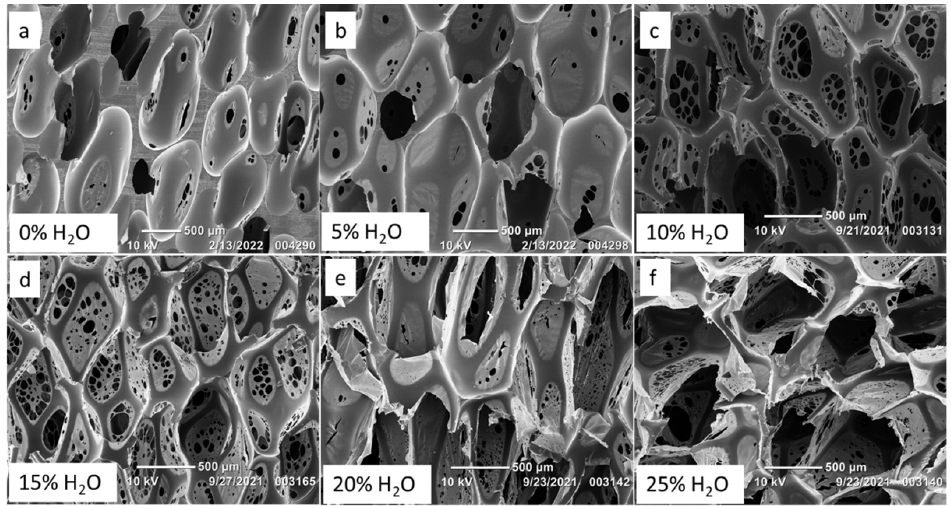
Figure 1. Scanning Electron Microscope (SEM) images of SMP foams synthesized with varying molar percentage of water. Increasing pore sizes and pinhole formation was observed in SMP foams ( a – f ) with increasing water content.